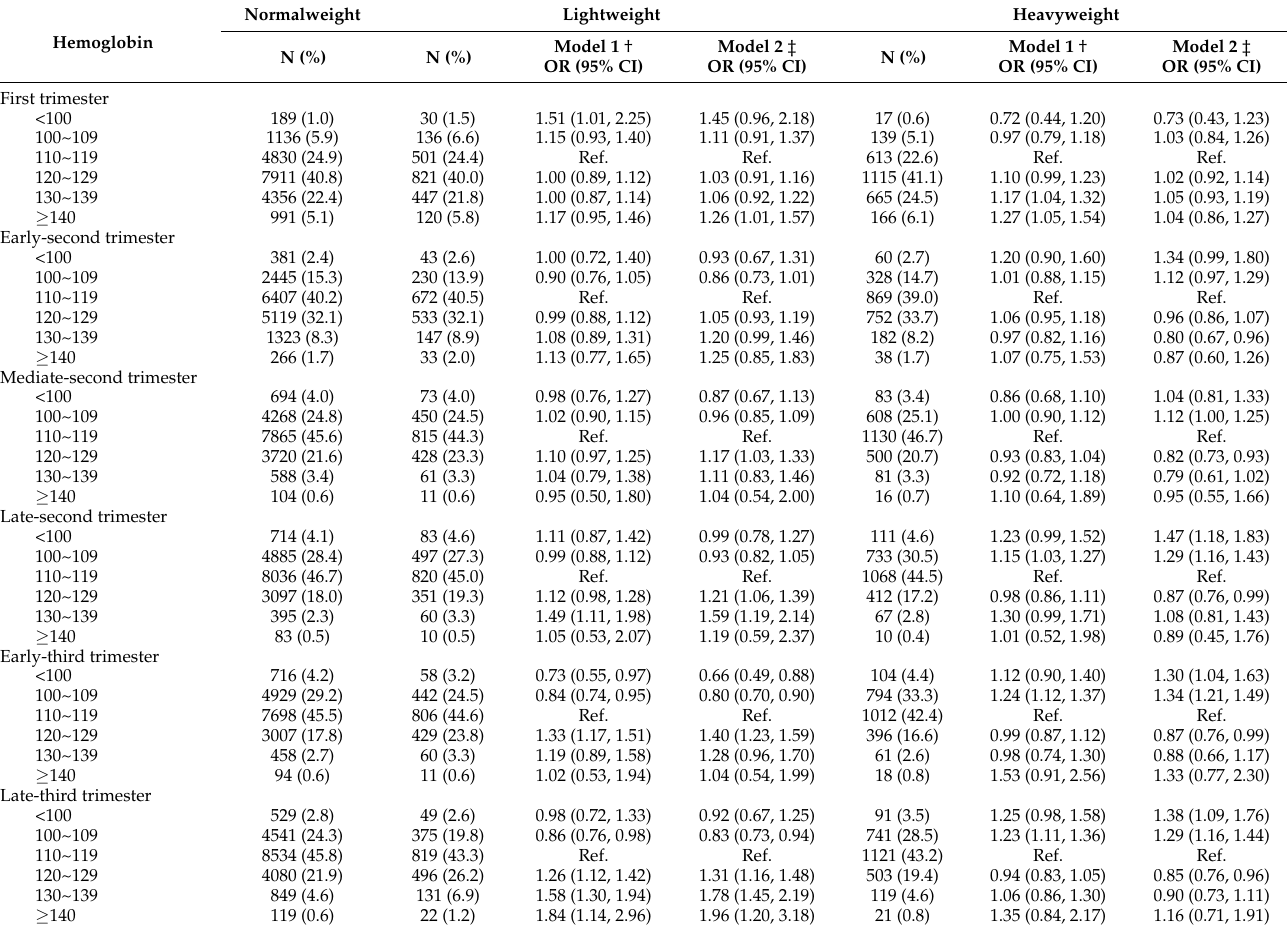
Table 2. Associations between maternal hemoglobin concentration at different periods and adverse birth outcomes.